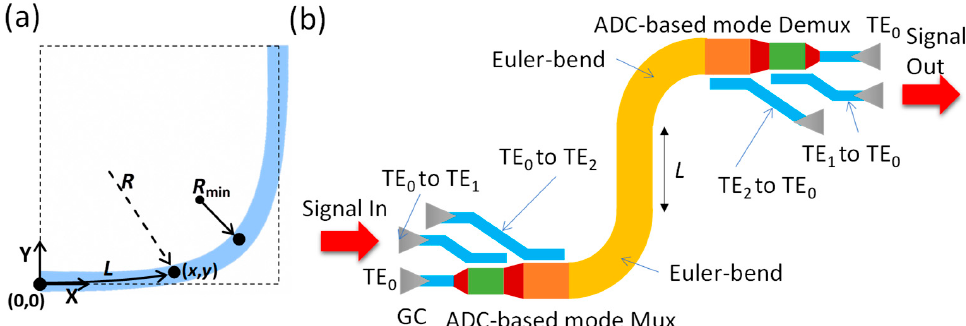
Figure 1. ( a ) Structure of a 90 ◦ sharp bend using a Euler curve. ( b ) Schematic of the SiPh integrated circuit, with MDM Mux/Demux and a straight multimode bus waveguide between two Euler bends.